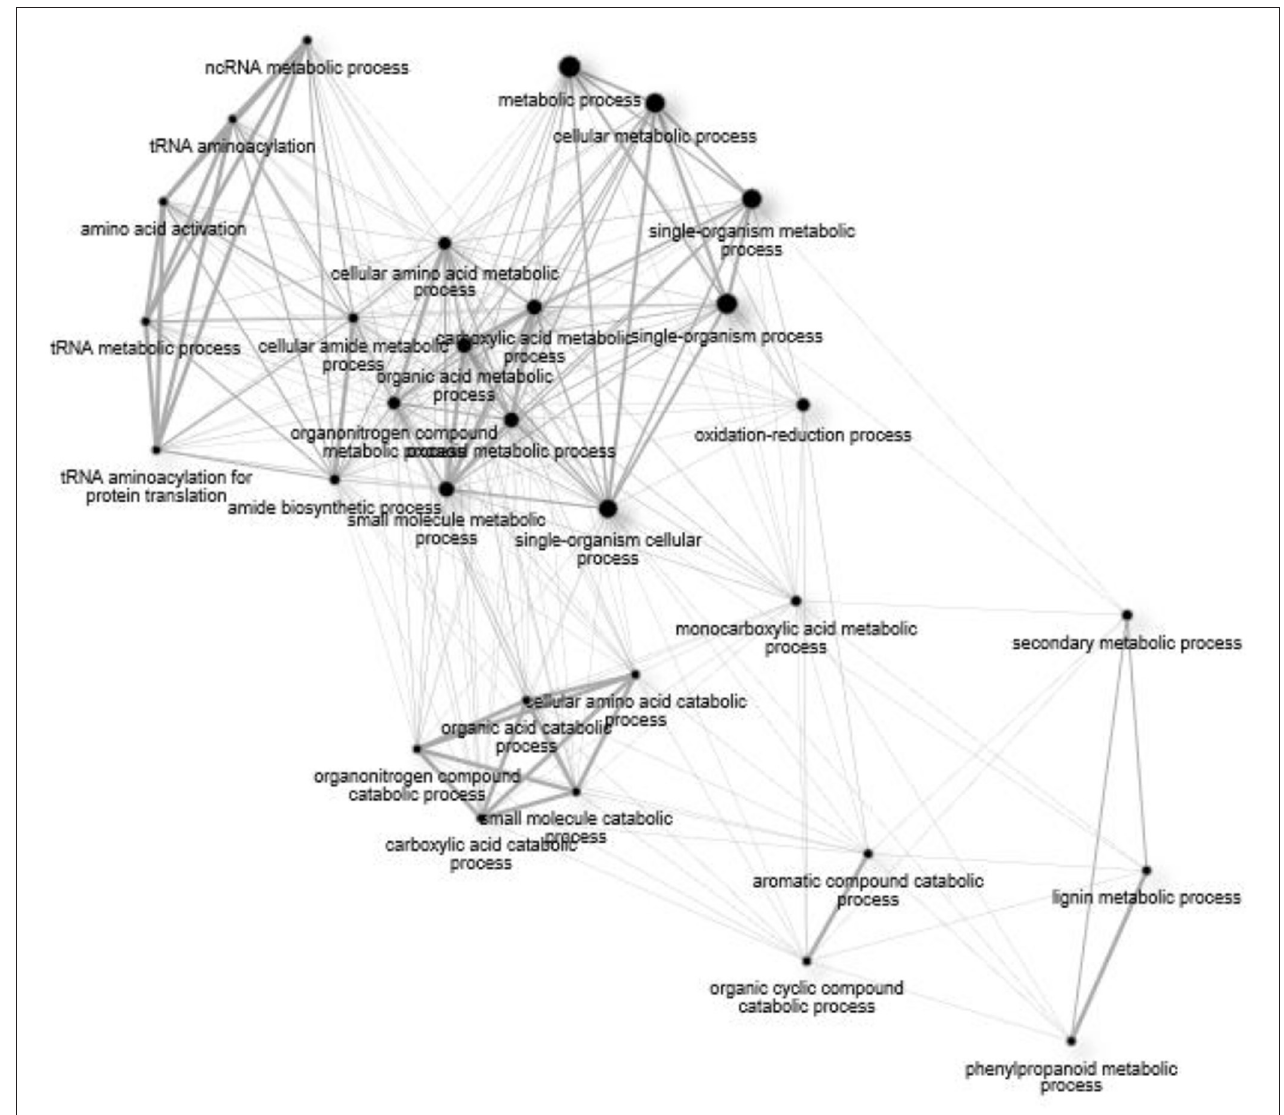
FIGURE 7 | A network of significant (FDR > 0.05) Gene Ontology (GO) terms for biological processes common to all treatment groups (15ADON, 3ADON, and NIV).